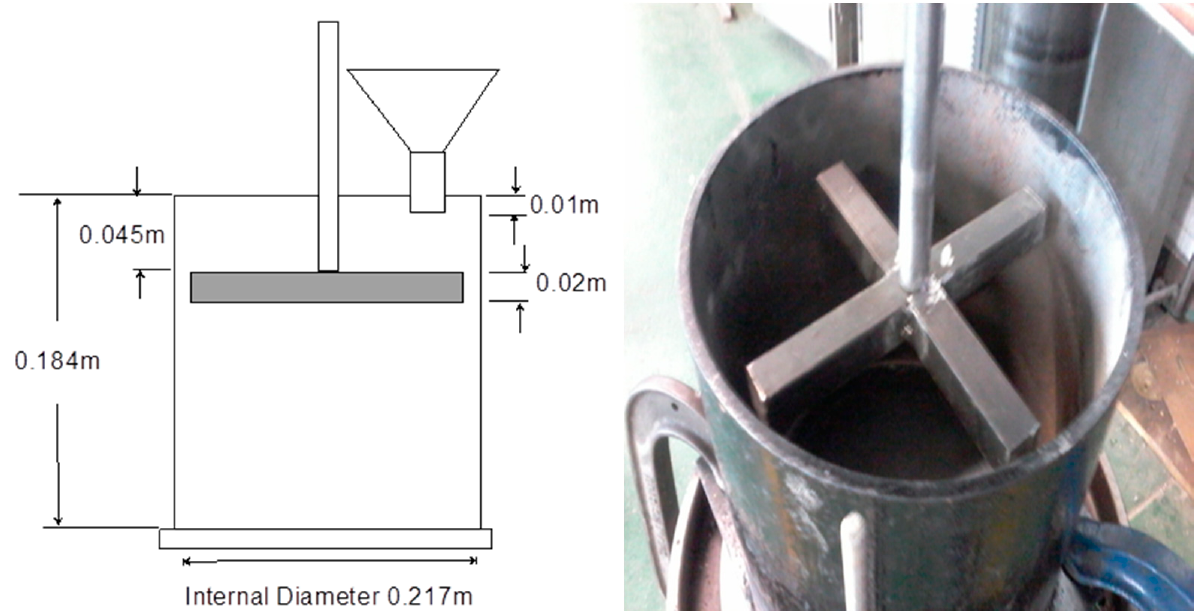
Figure 1. Picture and schematic of the Wits laboratory impact crusher used for experimentation.